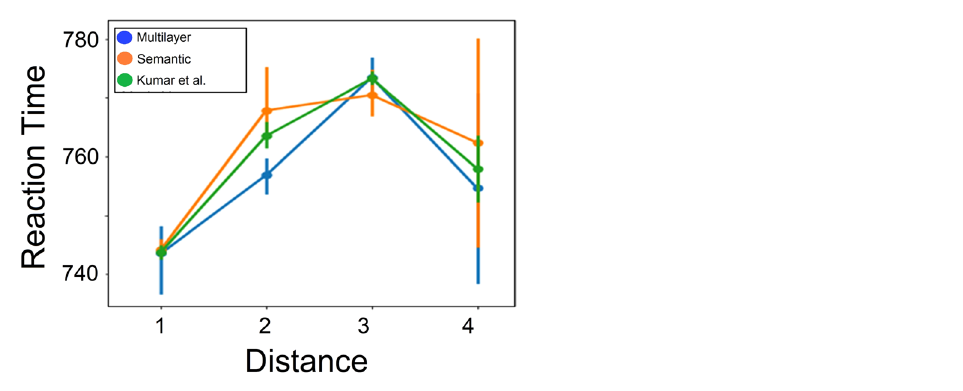
Figure 5. Multilayer network is more viable than the semantic network. RTs for relatedness judgments in the Kumar, Balota, and Steyvers 32 network (Green), semantic network (Orange) and multilayer network (Blue). Error bars represent standard deviations of the average RT. The error bar of the Kumar, Balota, and Steyvers 32 network represents the standard deviation of averages of subsets of